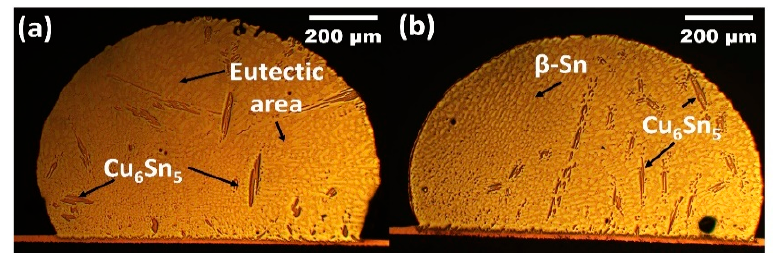
Figure 1. Microstructure of as-reflowed solder bulk for ( a ) non-reinforced SAC305 and ( b ) SAC305- KGC composite solders.